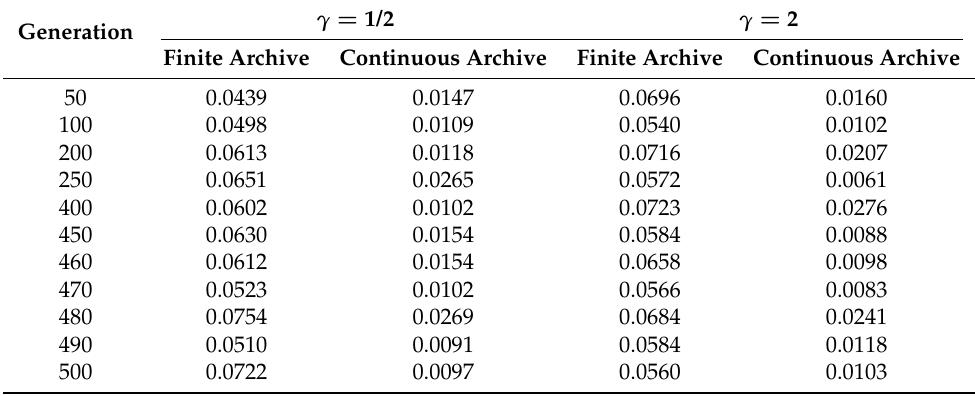
Table 4. ∆ p , q values for the Pareto front approximations for MOP (12) using the NSGA-II archives and with p = 1, q = −